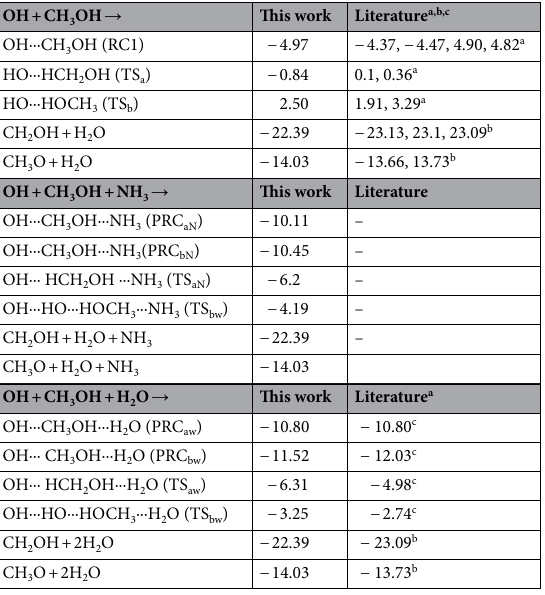
Table1. Enthalpies of reaction (∆ H rxn (0 K) in kcal mol −1 of OH + CH 3 OH reaction. a Nguynet al. 5 , b AT C T 35–37 , c Jara et al. 12